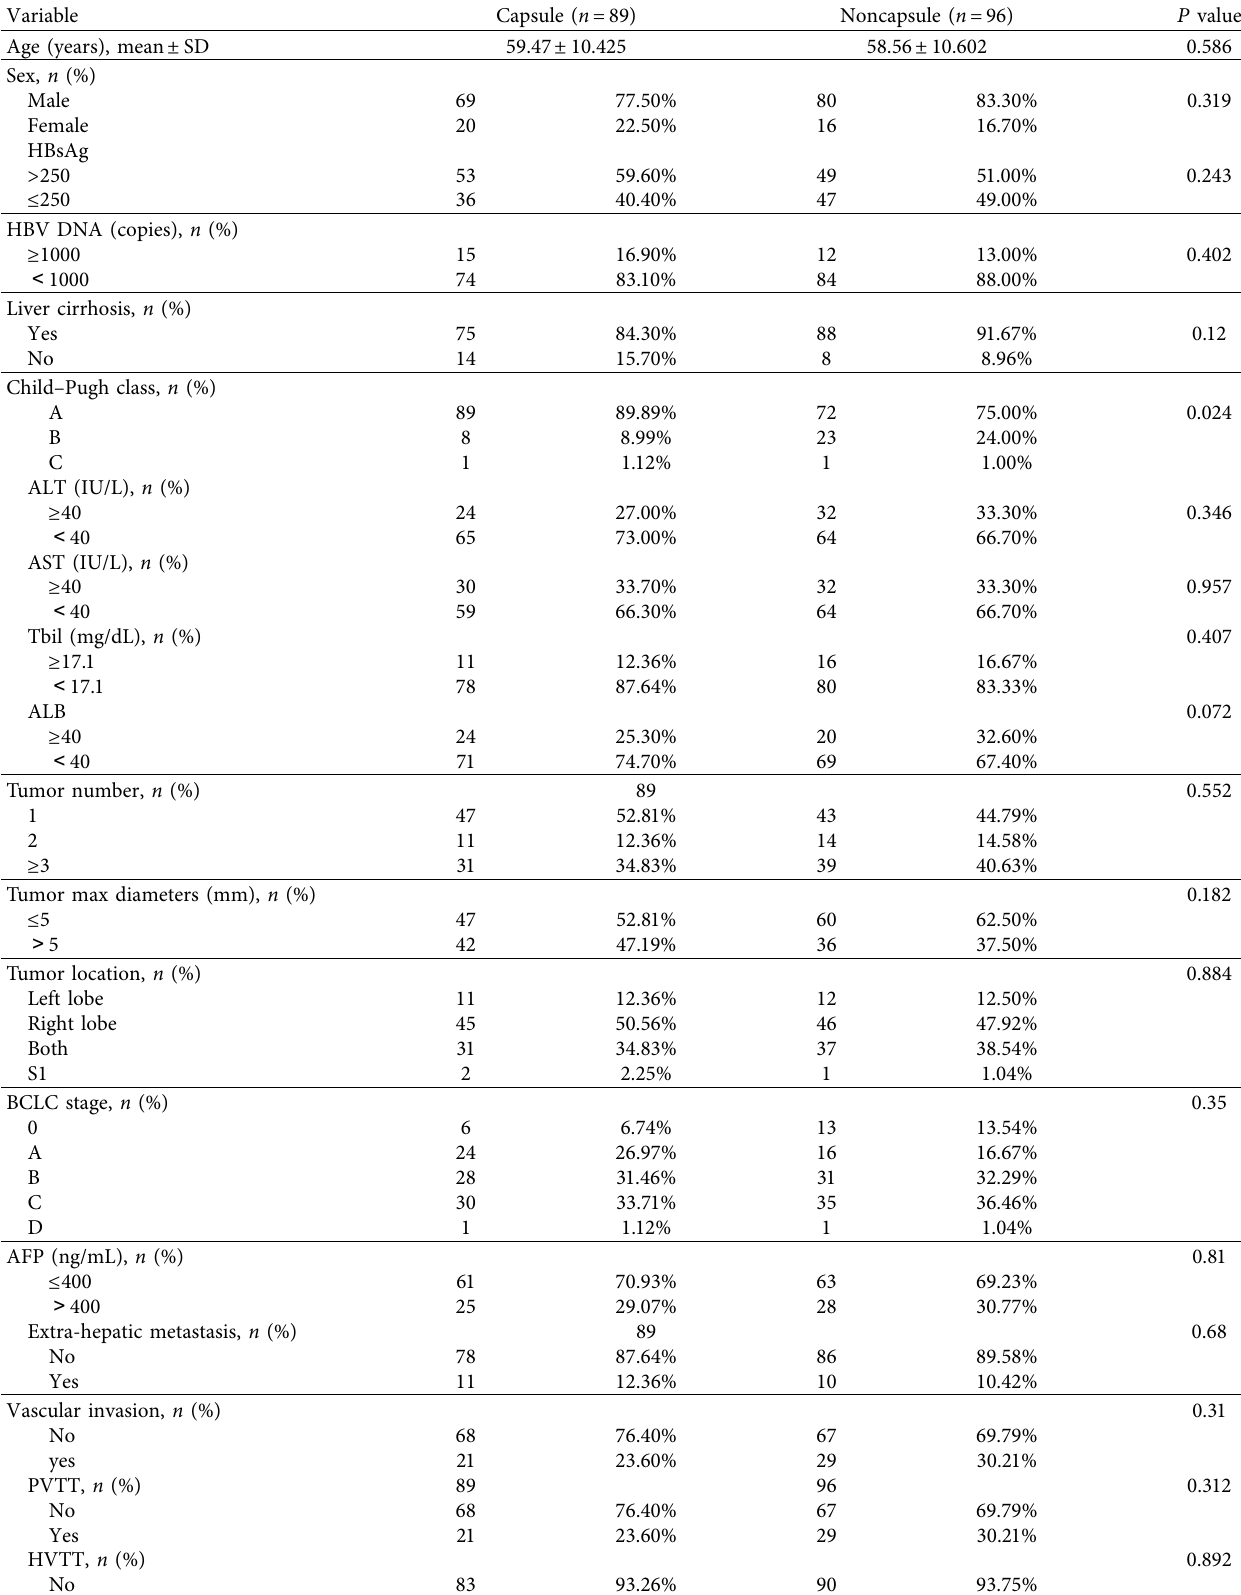
Table 1: Characteristics of